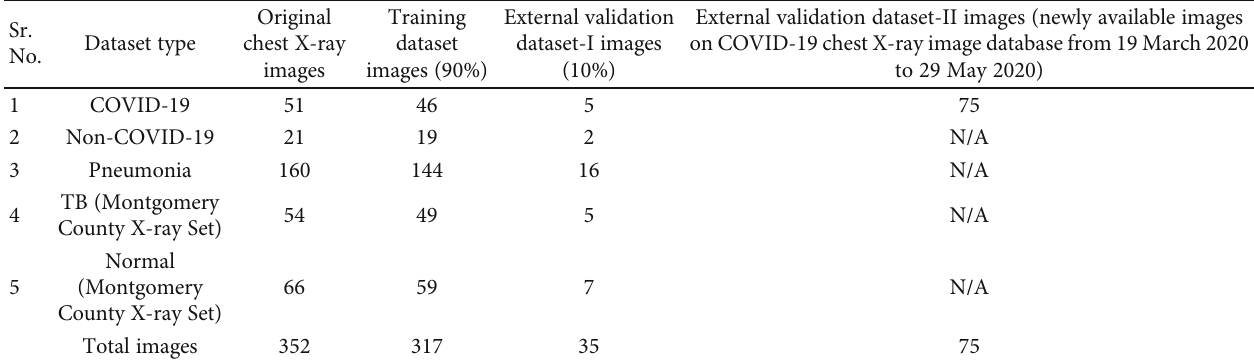
Table 1: Division of original images into training and external validation datasets.